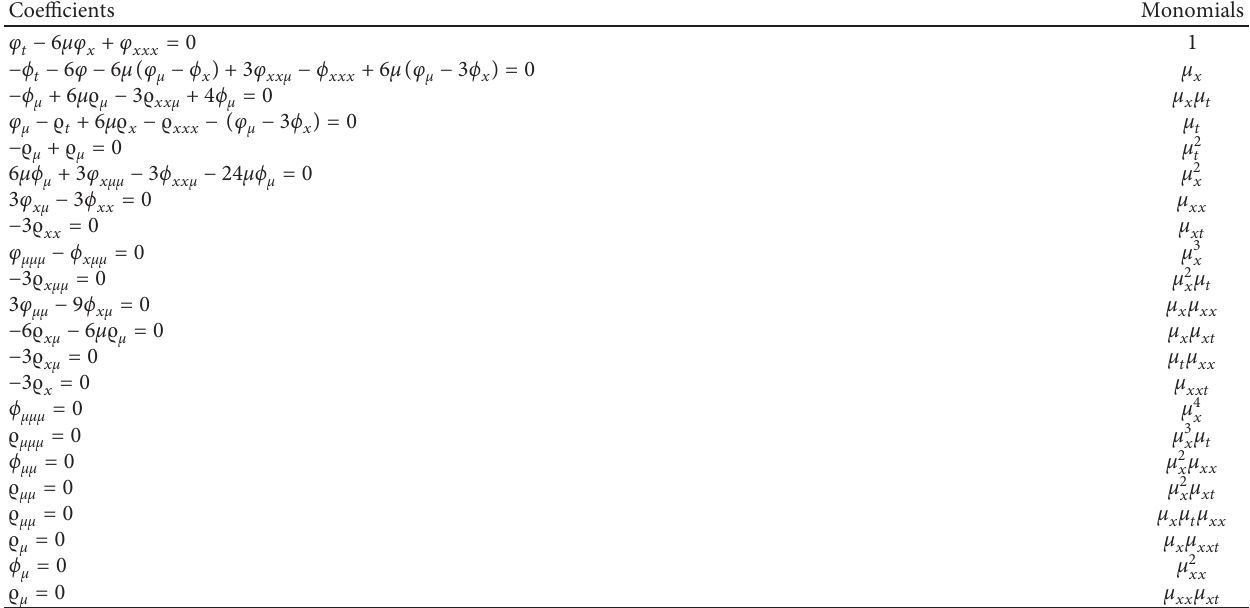
Table 1: The exact symmetries of the given partial differential equation (PDE).